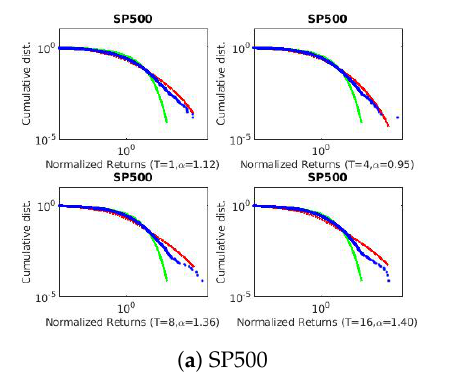
Figure A2. Lévy model fits for SP500 and SPC USA.